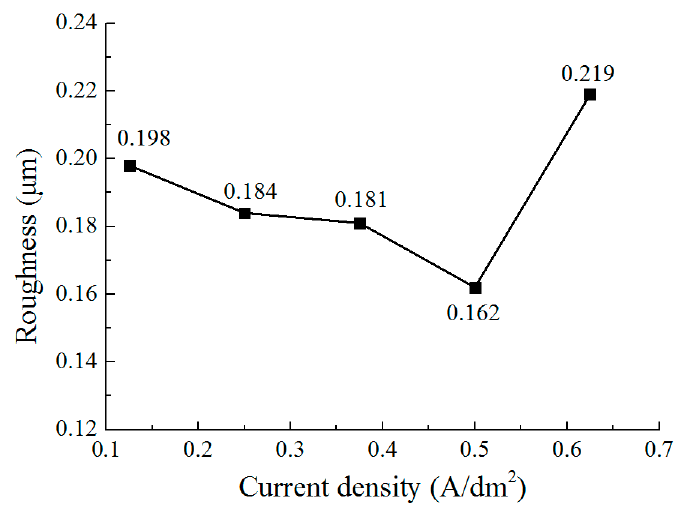
Figure 12. The effect of current density on the roughness.